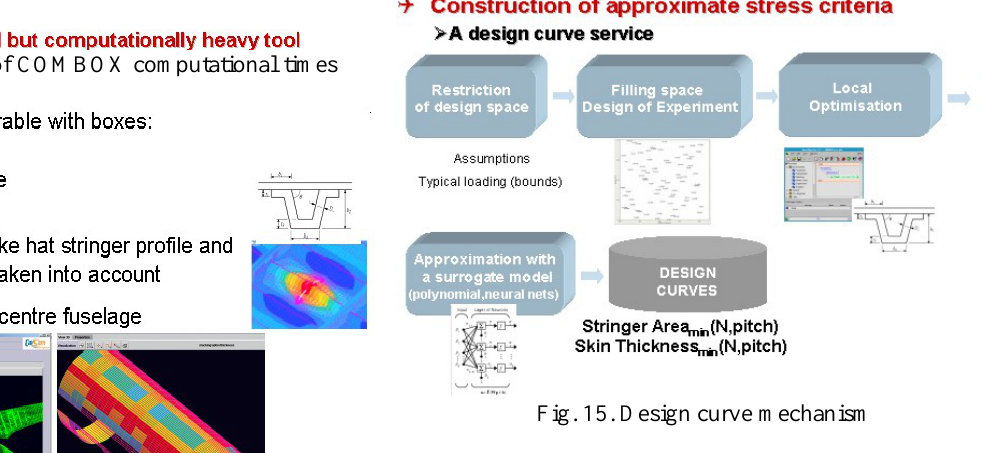
Fig. 15. Design curve